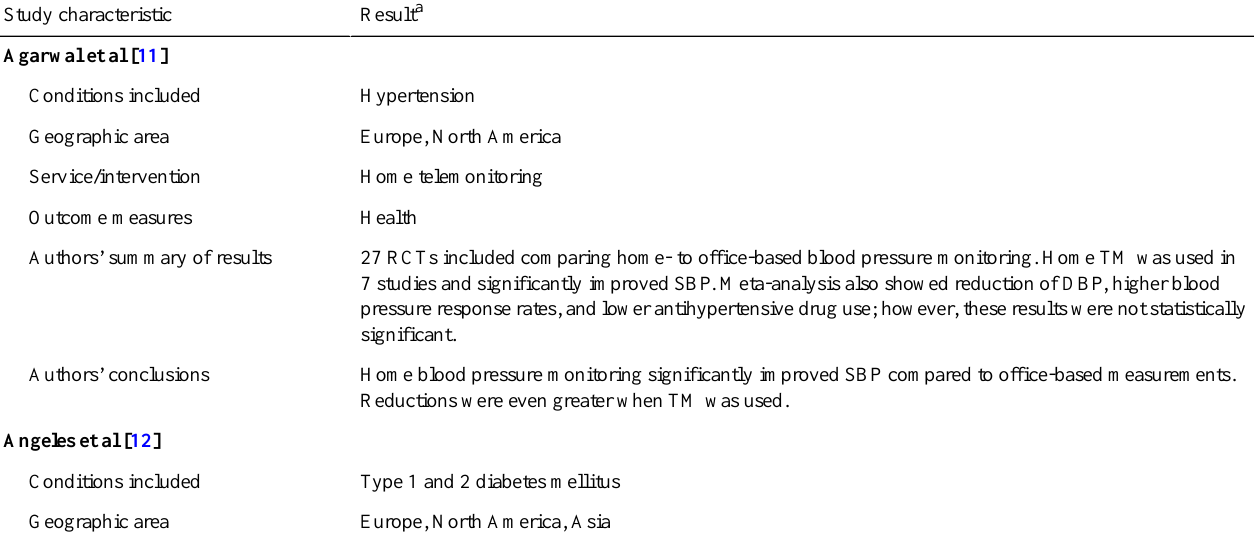
Table 3. Systematic reviews and meta-analyses in which eHealth interventions were shown to be